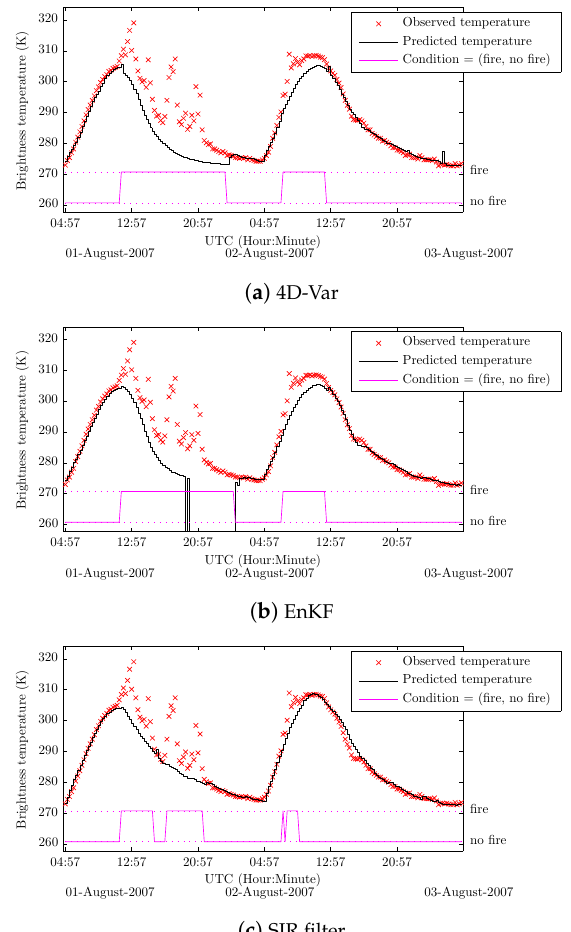
( c ) SIR filter Figure 6. Example of a detection of a brief morning fire reported by MODIS MOD14/MYD14 (on 2 August 2007). Level 1.5 pixel at ( 993,899 ) (Line, Column) with pixel center at ( 25.2829 ◦ S,31.2502 ◦ E ) . Detection at 10 − 3.5 FAR. Table 6. Table corresponds to results in Figure